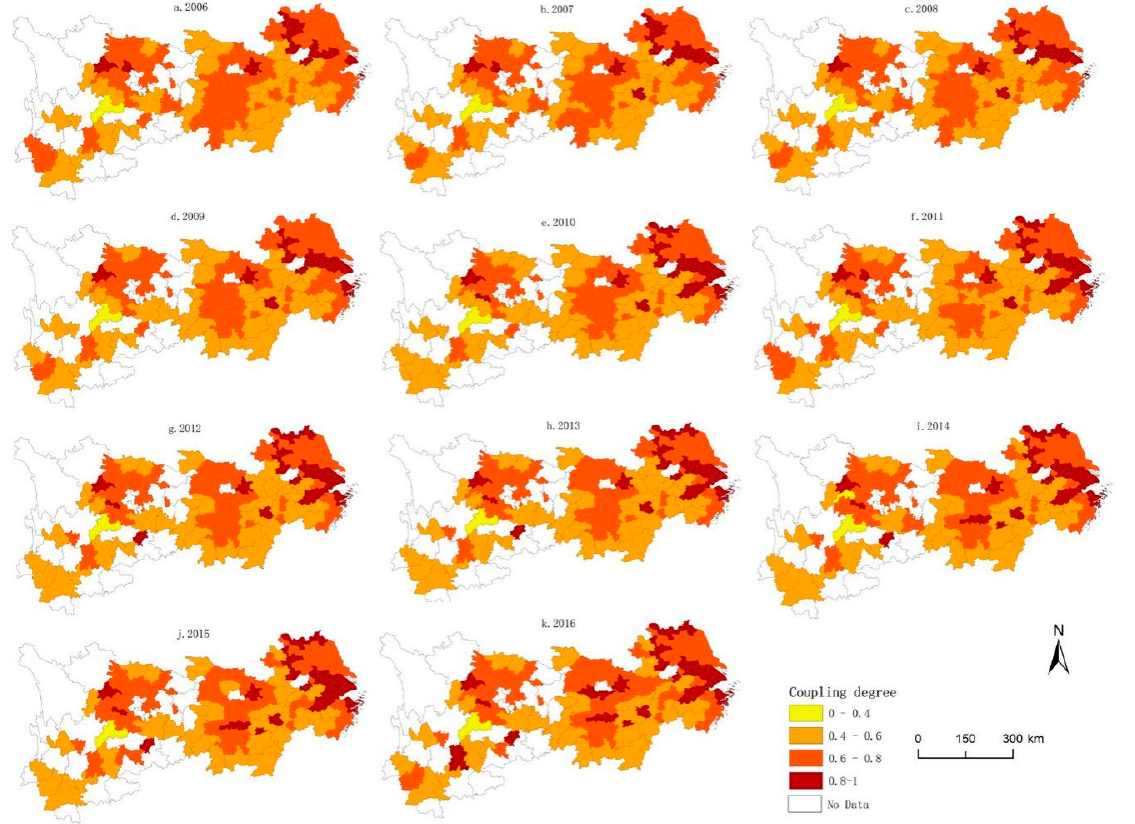
Figure 3. Spatial distribution of PLIU coupling degree in the YREB from 2006 to 2016. In terms of time scale, the coupling degree increased slowly, from 0.661 in 2006, to 0.681 in 2016, representing an increase of 3.7% in 11 years and an average annual increase of less than 0.4%. In 2016, the average coupling degree was 0.681. This year belongs to the running-in period, and there is still a large distance from the coupling coordination period. According to the current coupling development trend, the YREB will be in a run-in period for the next decades. That is, the population, land, and industrial urbanization will begin to balance and coordinate, but land urbanization will continue to occupy a dominant position, while population and industrial urbanization relatively lag behind. In terms of spatial pattern, there is a distinct spatial differentiation in the coupling degree. Cities of high value are mainly distributed in the developed areas, such as the Chengyu urban agglomeration, the middle reaches of the Yangtze River urban agglomeration, and the Yangtze River Delta urban agglomeration. The high value coupling zone is centered on the central city and on provincial cities with developed economies, dense population, and strong industry. This coupling zone will gradually diffuse and decrease outwardly in the form of circles. Cities with a low coupling degree are mainly distributed in Guizhou, Hunan, and